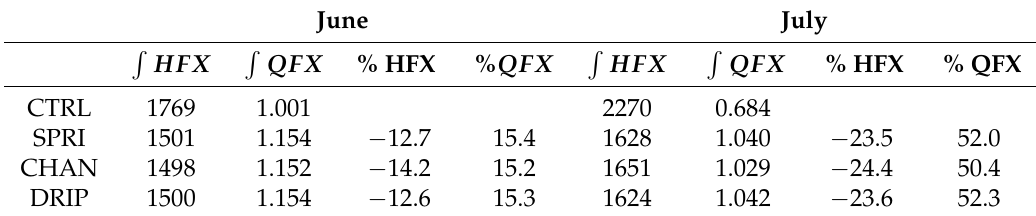
Figure 3. Daily cycle of the surface fluxes for the two months (( a ) June 2015 and ( b ) July 2015), averaged over the highlighted area of Figure 1 (red box). Table 1. Sensible (HFX) and upward moisture (QFX) fluxes for both June and July 2015 and all parameterizations. The first two columns of each part are the integrated monthly values, while the latter two columns are the integrated percentage changes with respect to the control